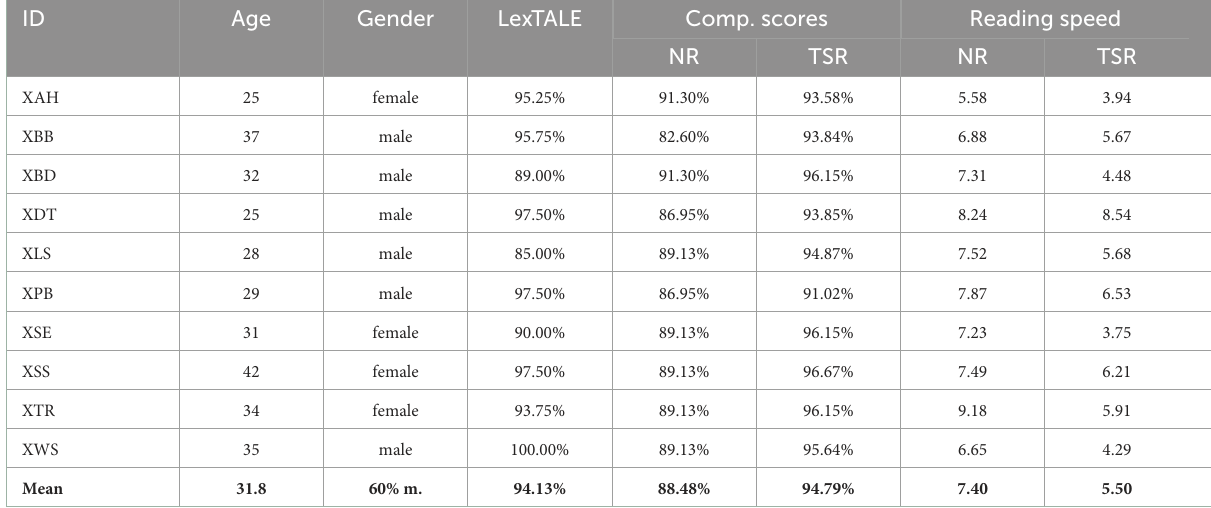
TABLE 4 Subject demographics for the new held-out test dataset, LexTALE scores, scores of the comprehension questions, and individual reading speed (i.e.,seconds per sentence) for each task. ID Age Gender LexTALE Comp.